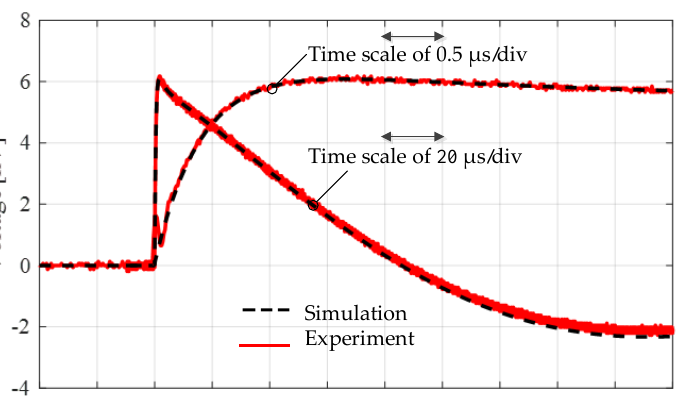
Figure 13. Comparison of the simulation and experimental waveforms in Case 12.